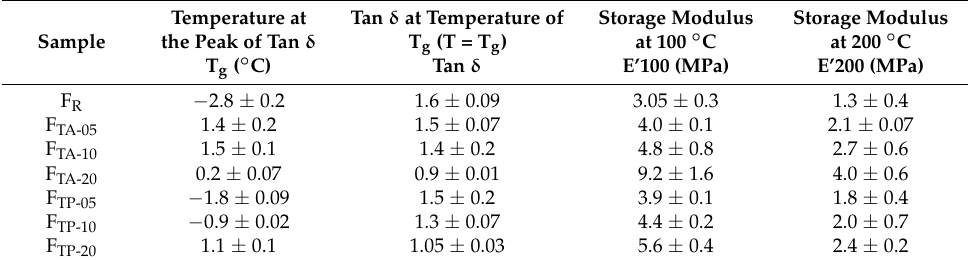
Table 4. Mechanical parameters obtained from tensile tests at room